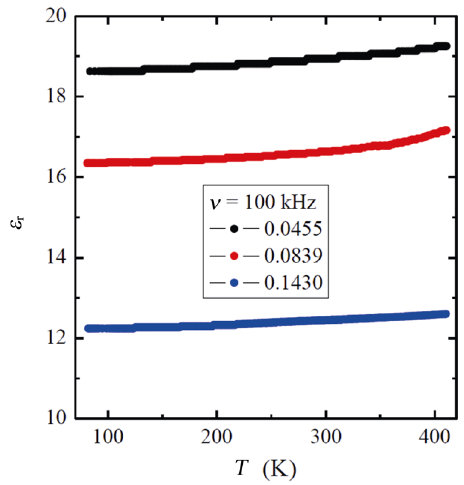
Fig. 9 Temperature dependence of ε r at 100 kHz for Gd 3+ -doped samples when x = 0.0455, 0.0839, and 0.1430.